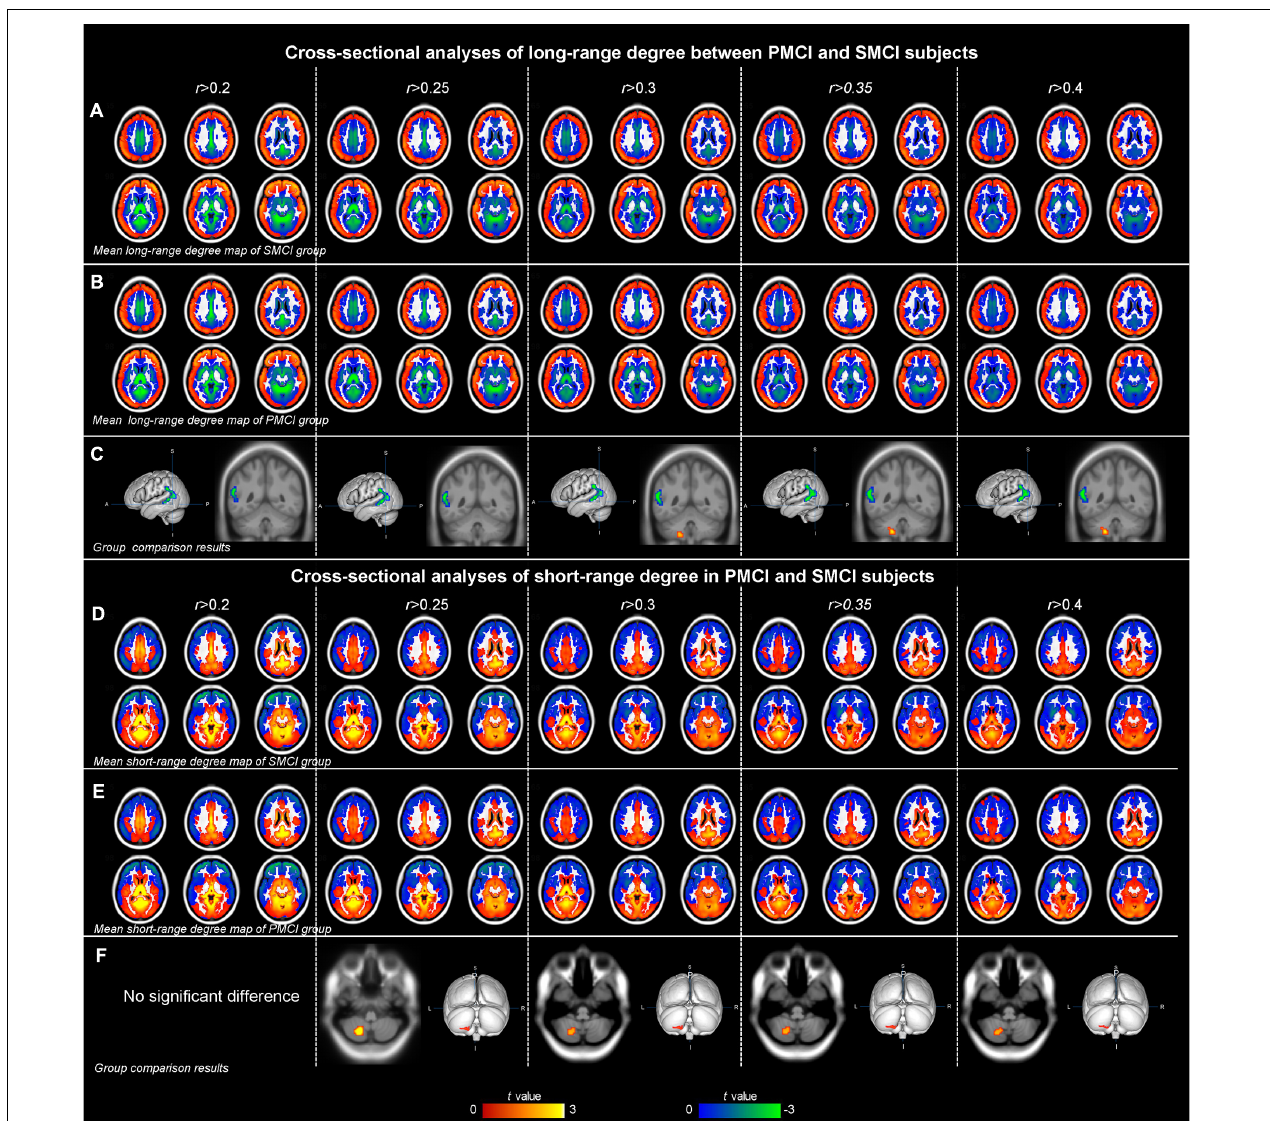
FIGURE 3 | The mean degree maps of the PMCI group and stable MCI (SMCI) group and baseline cross-sectional analyses results across the correlation threshold range of 0.2–0.4. The upper panel shows the mean long-range degree maps of SMCI (row A ) and PMCI (row B ) groups and the between-group comparison results (row C ). In row (C) , the green–blue/red–yellow indicates the brain regions with significantly decreased/increased long-range degree in the PMCI group compared with the SMCI group at baseline. The lower panel shows the mean short-range degree maps of SMCI (row D ) and PMCI groups (row E ) and the between-group comparison results (row F ). In row (F) , the red–yellow indicates the brain regions with significantly increased short-range degree in the PMCI group compared with the SMCI group at baseline. (Statistical level: p < 0.01 with a minimal cluster size of 48 voxels, which yields an Alphasim correction threshold of p <